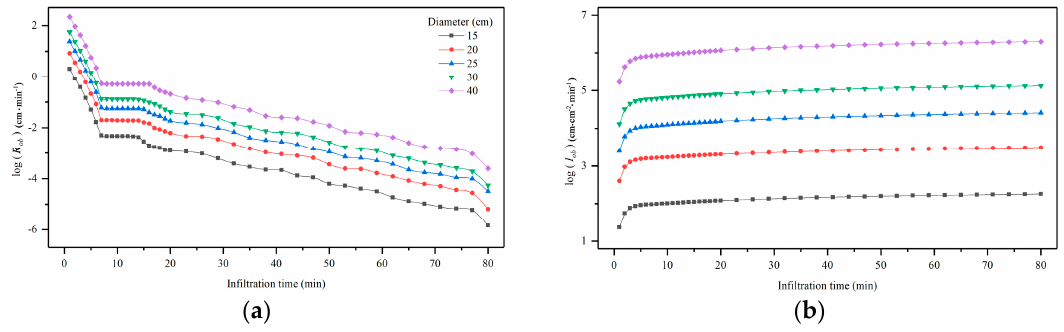
Figure 3. The log-transformed measured infiltration rate ( a ) and cumulative infiltration ( b ) with di ff erent inner-ring diameter and the same outer bu ff er index ( di = 15, 20, 25, 30 and 40 cm, bi = 0.33). R ob and I ob are the infiltration rate and cumulative infiltration of di ff erent inner-ring diameters, respectively.